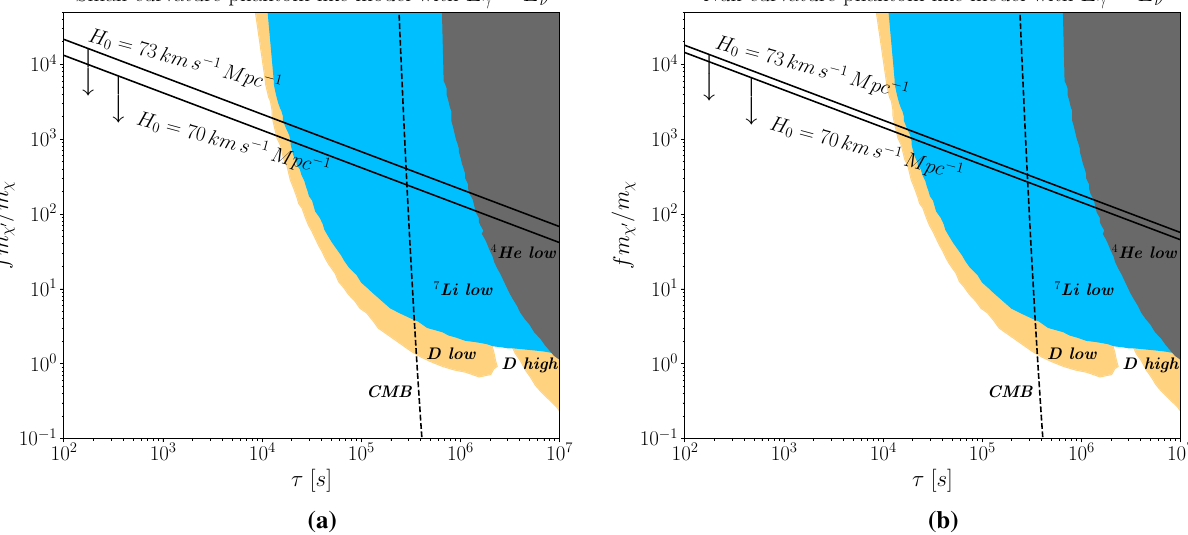
Figure 3. BBN bounds based on light element abundances, and CMB constraint stemming from spectral distortion of the CMB are presented. We overlay the theoretical prediction for H 0 using our non-thermal dark matter production mechanism. In ( a ) we display the results for E γ gamma-rays produced after the χ ′ text for